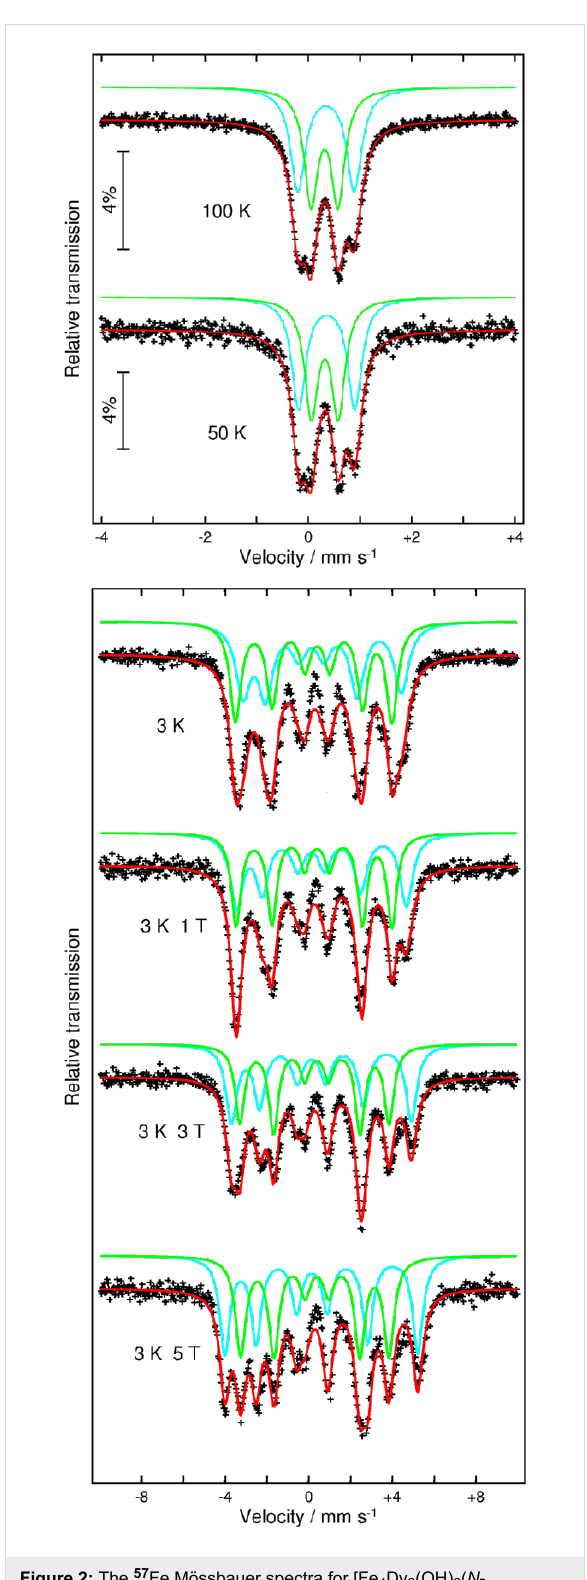
Figure 2: The 57 Fe Mössbauer spectra for [Fe 4 Dy 2 (OH) 2 ( N - nbdea) 4 ((CH 3 ) 3 CCOO) 6 (N 3 ) 2 ] at 100 and 50 K (top); at 3 K in zero- applied magnetic field and at 3 K in applied magnetic fields of 1, 3 and 5 T (bottom). See Table 1 for the fitting